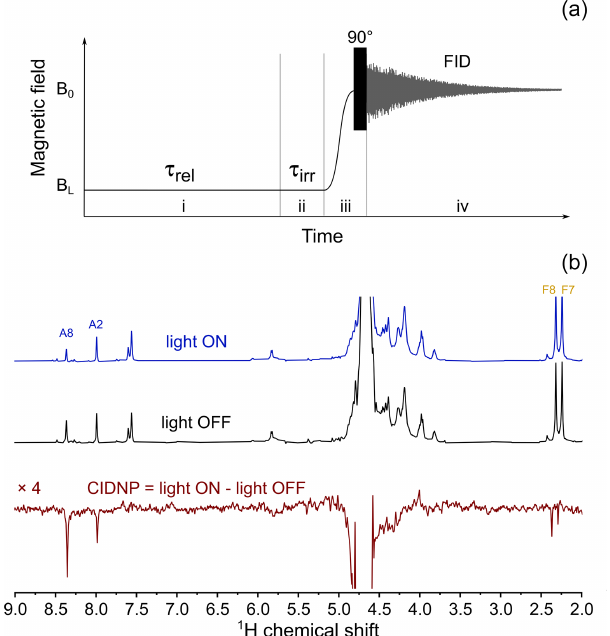
Figure 6. (a) Experimental protocol for measuring the CIDNP field dependence. In stage (i) the sample relaxes in low field, B L , for τ rel = 5s. Then, in stage (ii) the LED is either switched on (in “light ON” experiment) or stays switched off (in “light OFF” ex- periment) for τ irr = 0 . 5s. In stage (iii) the sample is transferred to high field, B 0 , and a 90 ◦ RF pulse is applied. In stage (iv) nuclear spin free-induction decay is acquired. (b) Top spectrum: 400MHz 1 H NMR spectrum obtained using the protocol shown in panel (a) , with 3W 520nm LED switched on during stage (ii) of the pro- tocol, B L = 4mT; middle spectrum: 400MHz 1 H NMR spectrum obtained using the protocol shown in panel (a) , LED is switched off during stage (ii) of the protocol, B L = 4mT; bottom spectrum: B L = 4mT CIDNP spectrum which is the difference between “light ON” and “light OFF” spectra taken in this field.